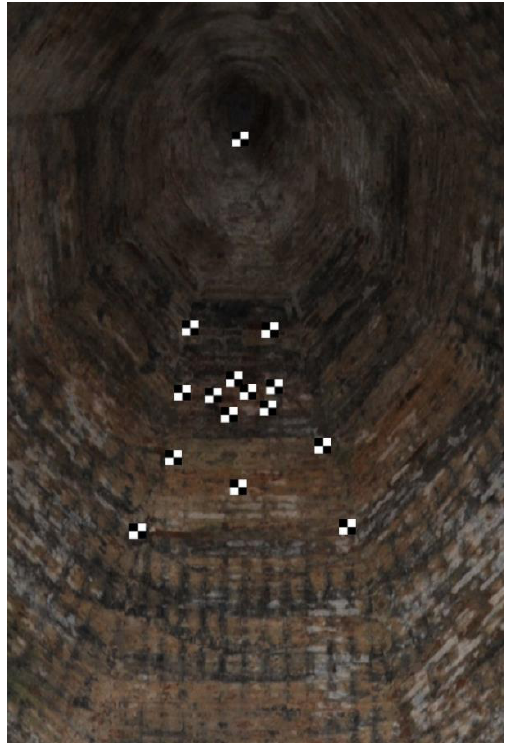
Figure 8. Tie points on 2016 surveyed image.